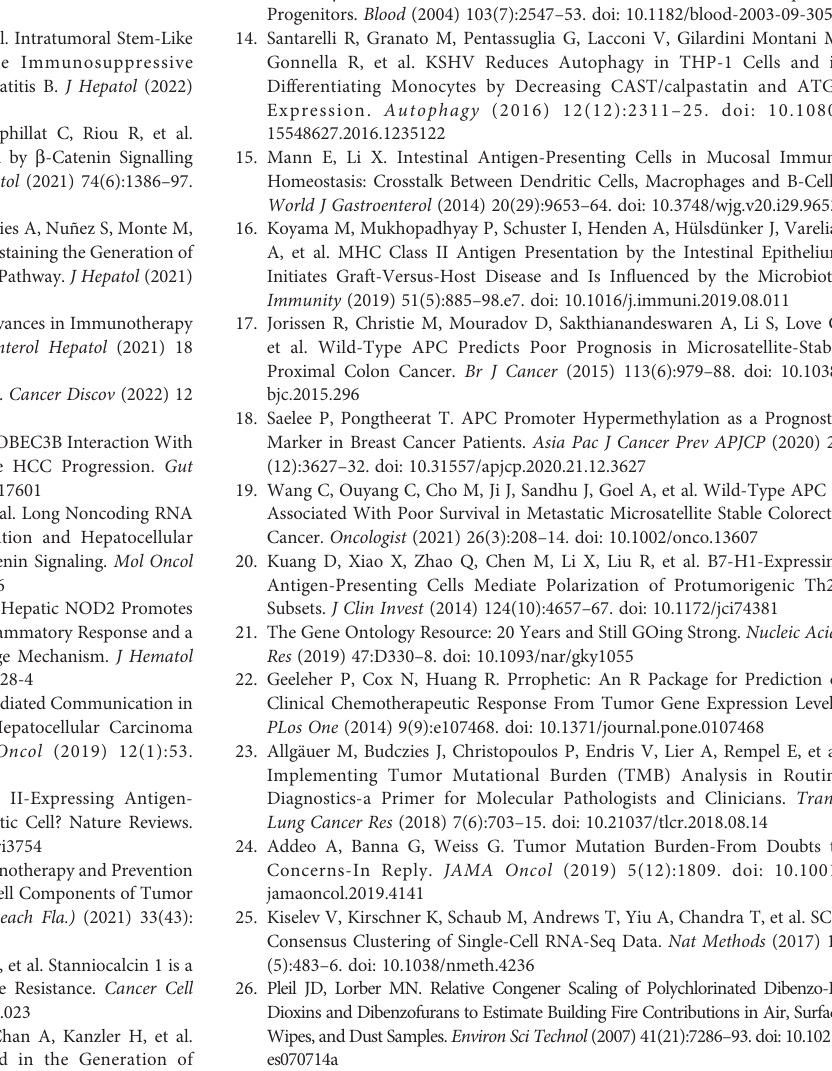
Supplementary Figure 1 | (A) CDF curves for selecting optimal antigen- presenting cells related subtypes. (B) CDF curves for selecting optimal APCs related genomic subtypes. Supplementary Figure 2 | ROC curves of 4 published signatures in the TCGA cohort. Supplementary Figure 3 | (A) The expression levels of 12 hub genes between risk groups. (B) The comparison of risk score for patients with stable disease or progressive disease (SD/PD) and patients with complete response or partial response (CR/PR) in the IMvigor210